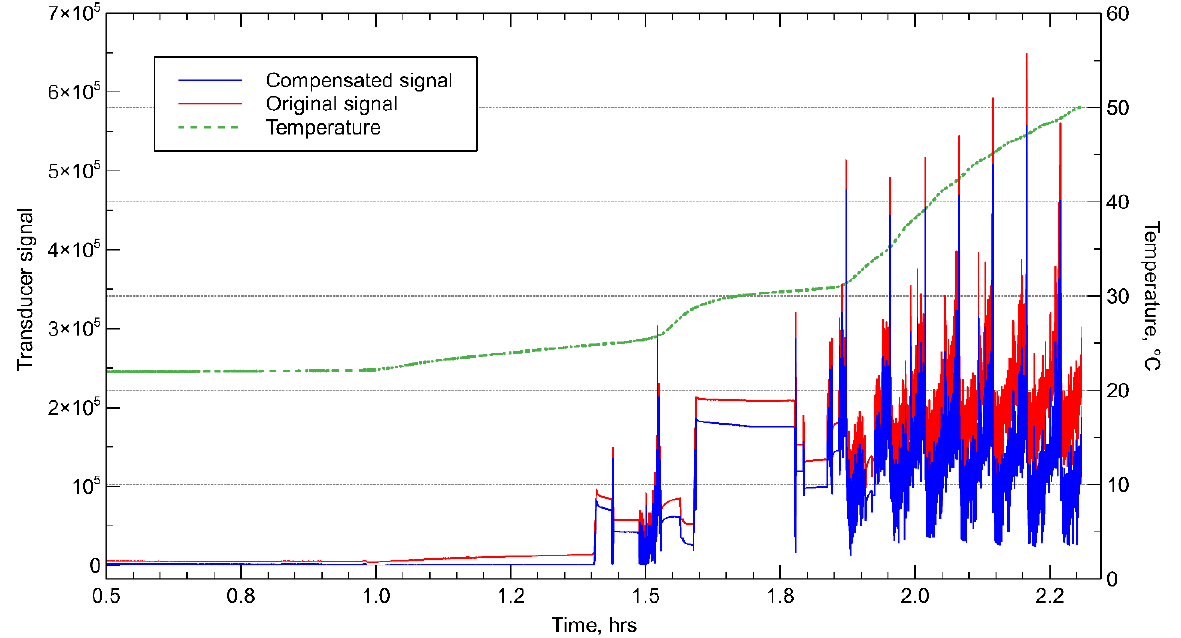
Figure 12. Influence of temperature on the recorded signal.